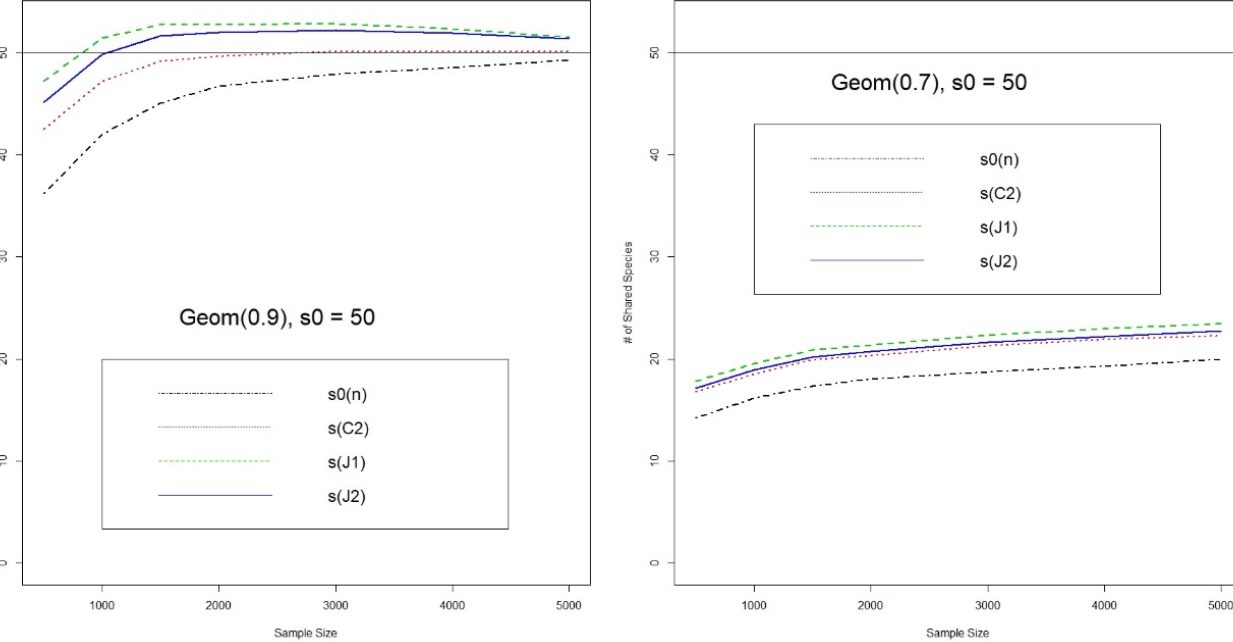
Figure 2. Estimates for the Number of Shared Species (Numbers of species in two populations are s 1 = 100 & s 2 = 100, and the number of shared species is s 0 = 50; J 1 & J 2: 1st & 2nd Jackknife estimates, C 2: Chao’s estimate, s 0 ( n ): number of observed shared species).